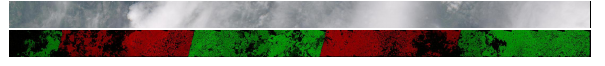
Figure 19. Test image B, lowest 500 rows, 10980 columns, top: ortho image, bottom: cloud-heights, green: positive heights above ground, red: negative heights above